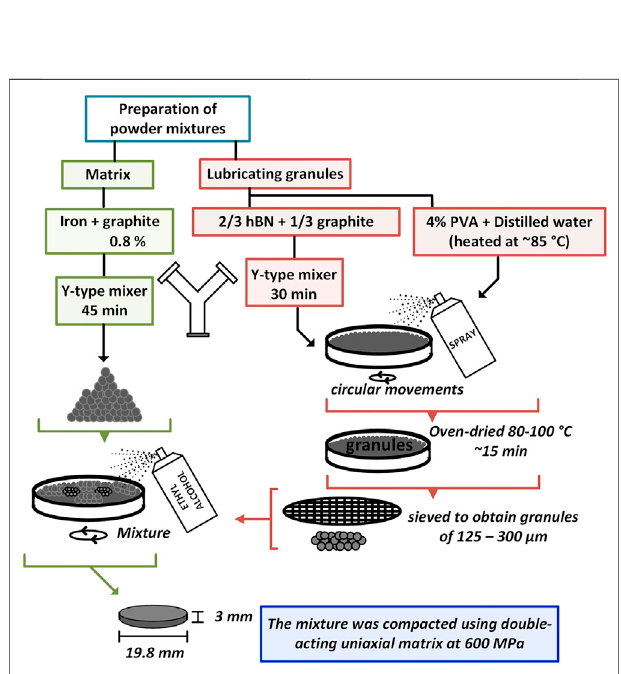
FIGURE 1 | Sample production schematic fl ow-process diagram.